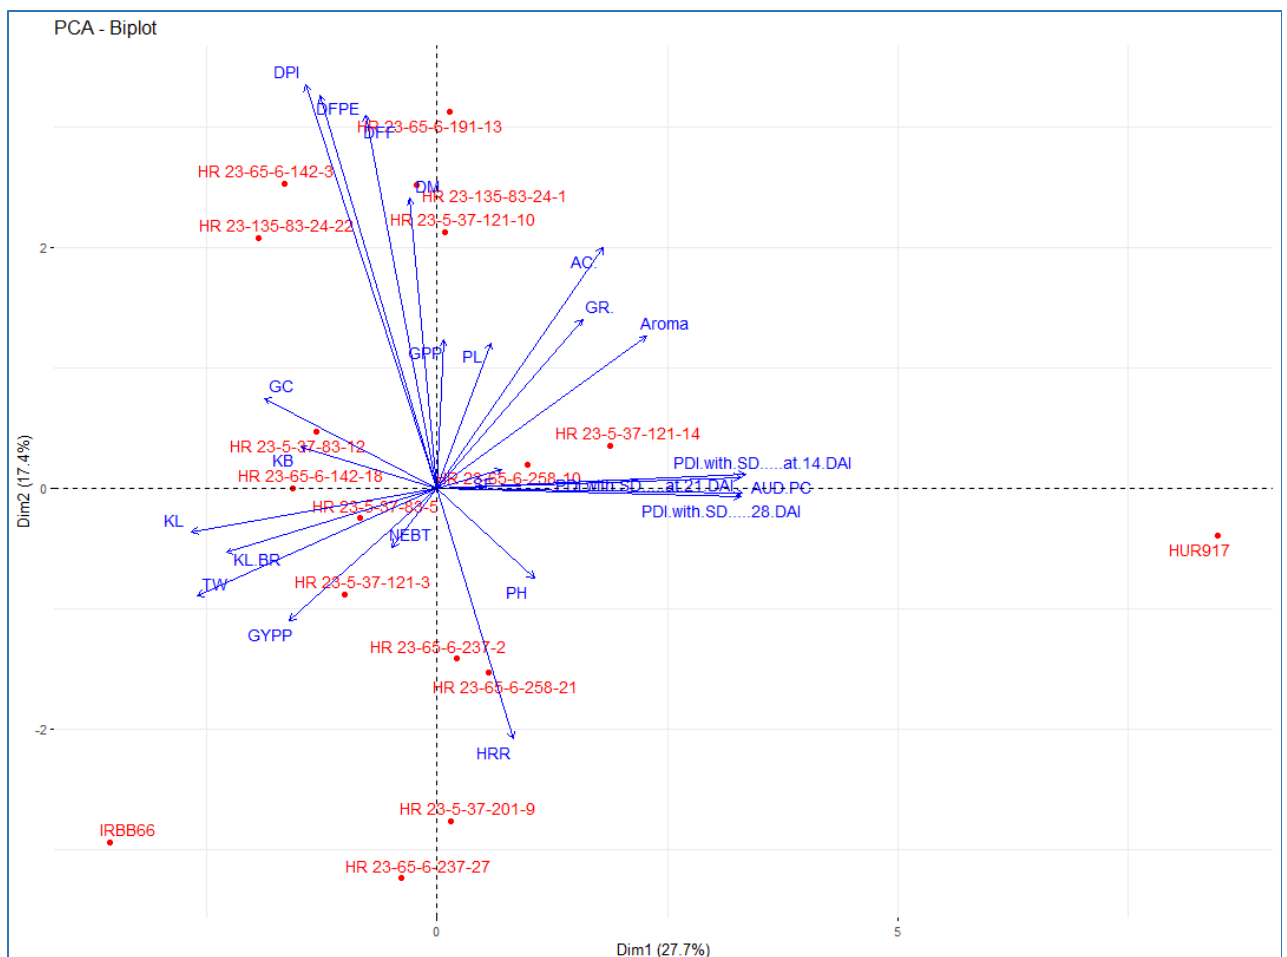
Figure 6. Biplot diagram of 21 traits including yield, quality and other agro-morphological traits in the parents and NILs. Table 6. Duncan ’ s Multiple Range test (DMRT) for analysis of pairwise differences among parents and NILs of HUR 917/IRBB66.